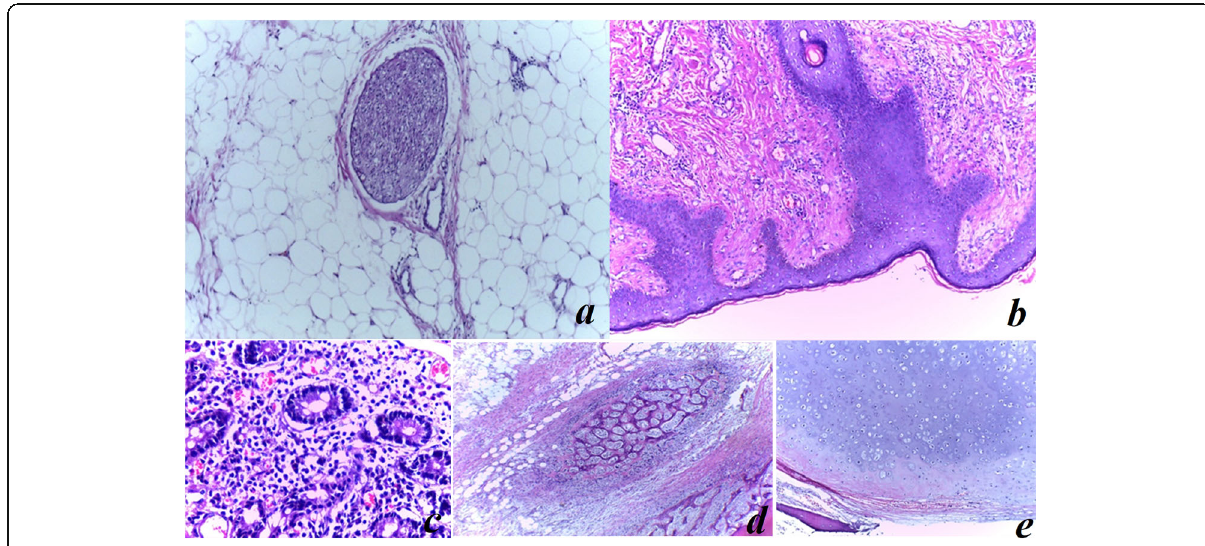
Fig. 3 Microscopic picture showing a × 20 H&E slide fat and nerve, b × 20 H&E slide of skin, c × 40 H&E slide of glandular epithelium, d × 20 H&E slide of bone and fat, e × 20 H&E slide of mature cartilage and